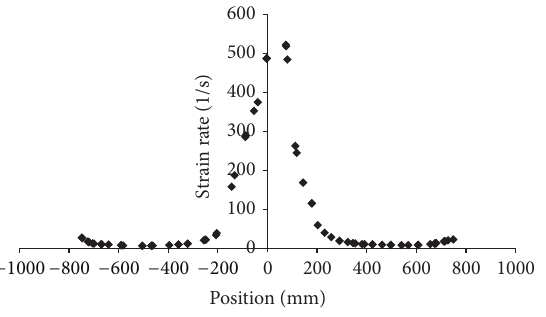
Figure 9: Strain rate along the radial line of 𝑥 = 359 mm, close to the flame region.